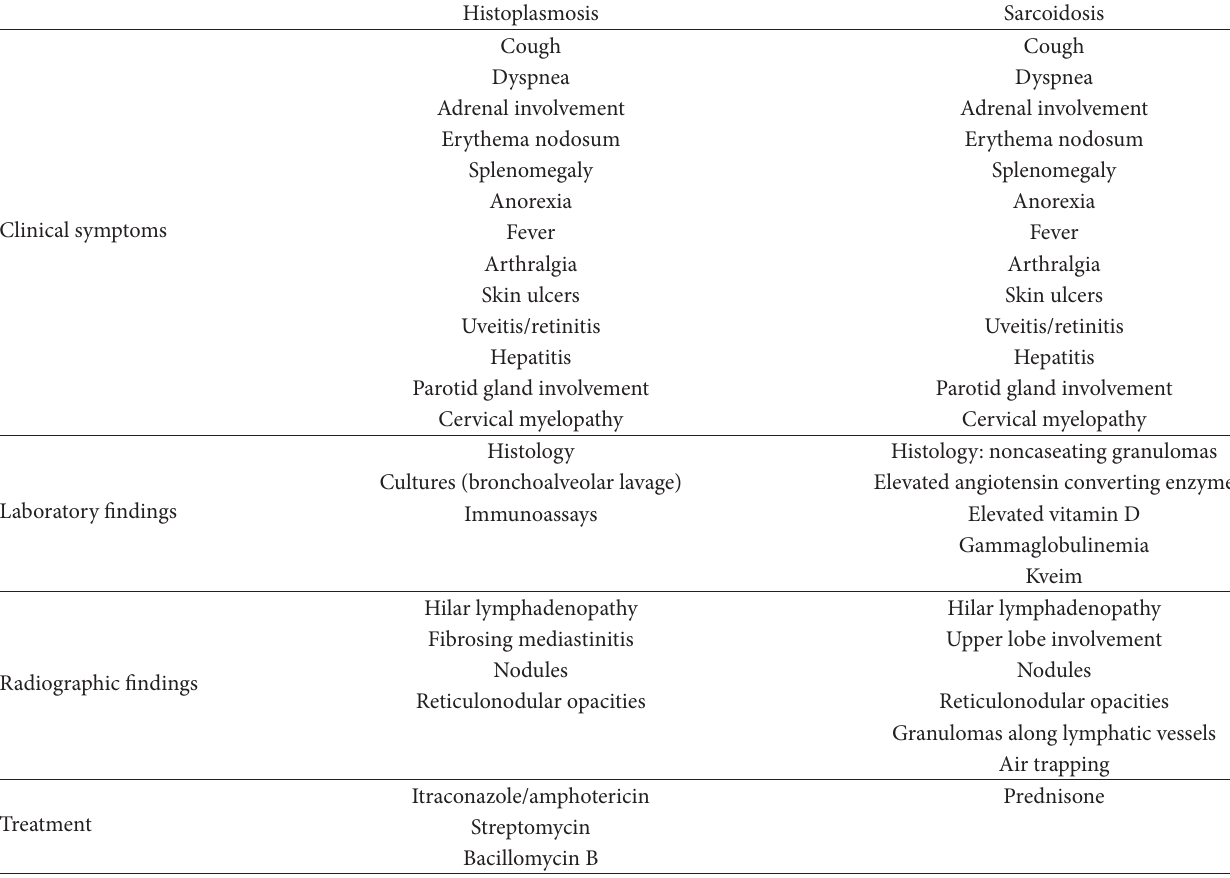
Table 1: Shared characteristics and differences between histoplasmosis and